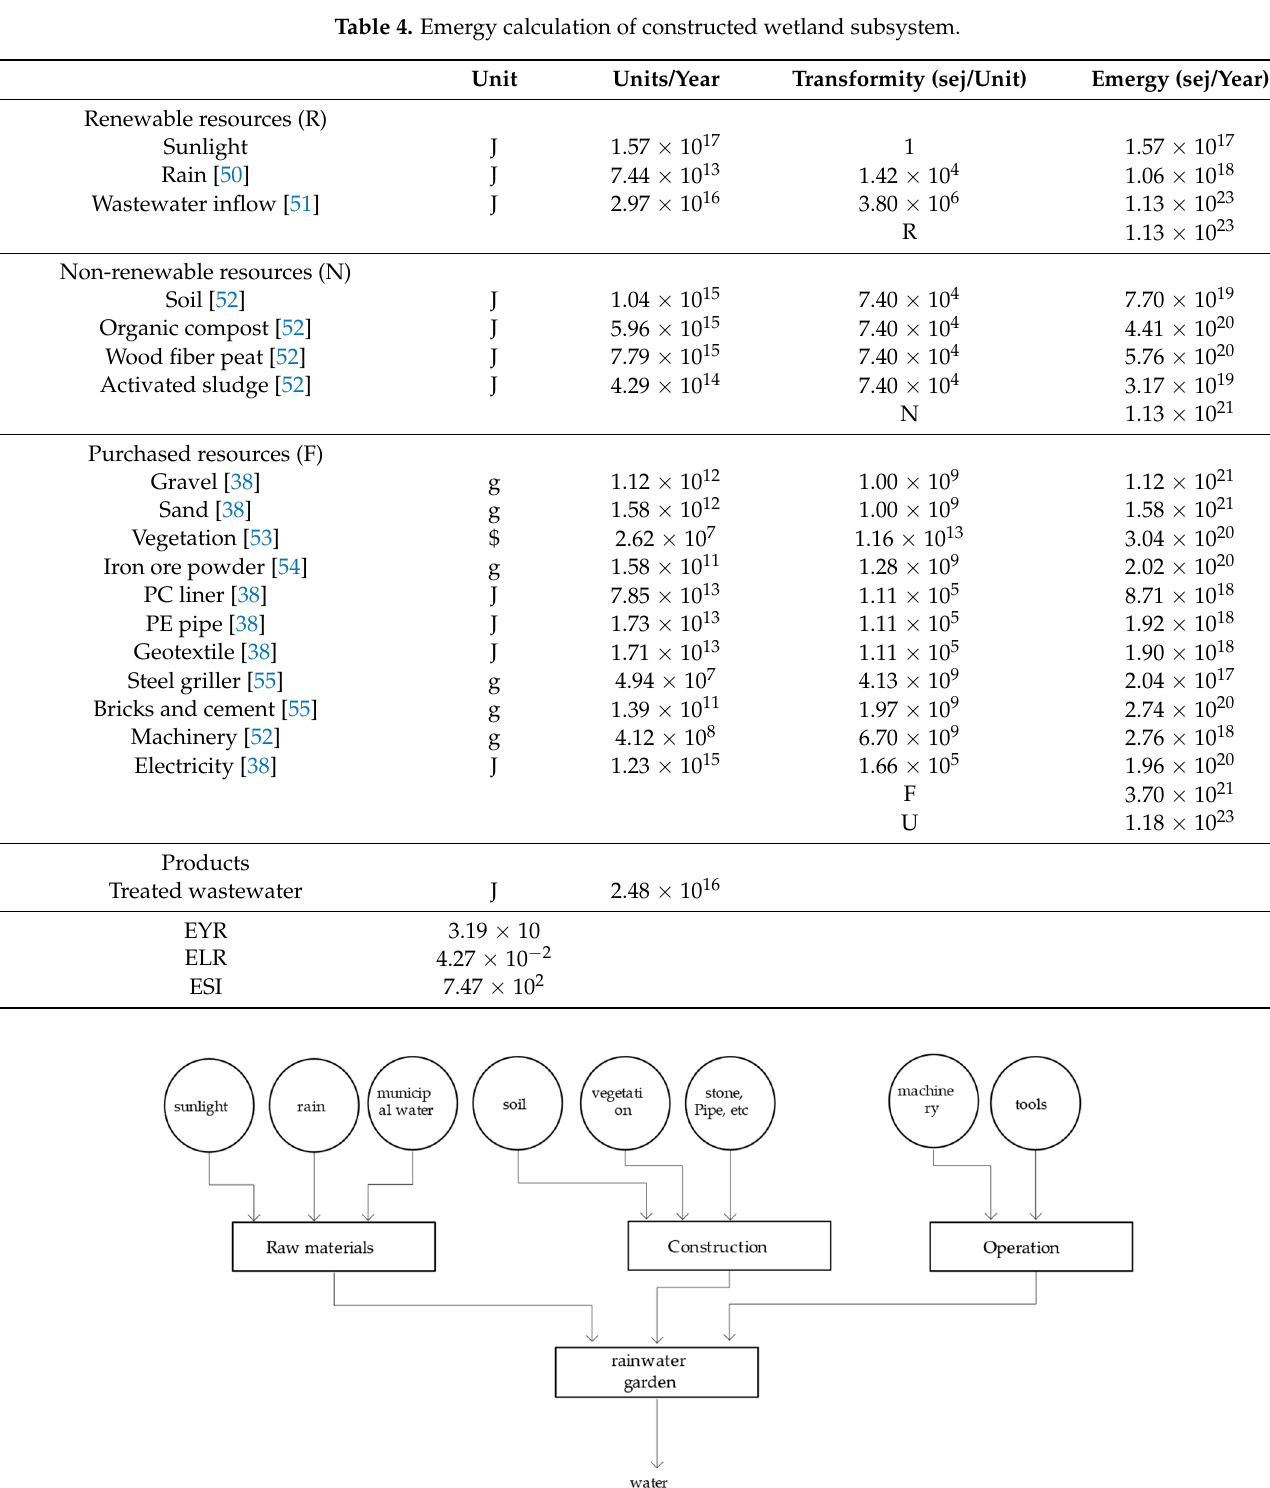
Figure 6. System diagram of the rainwater garden system.